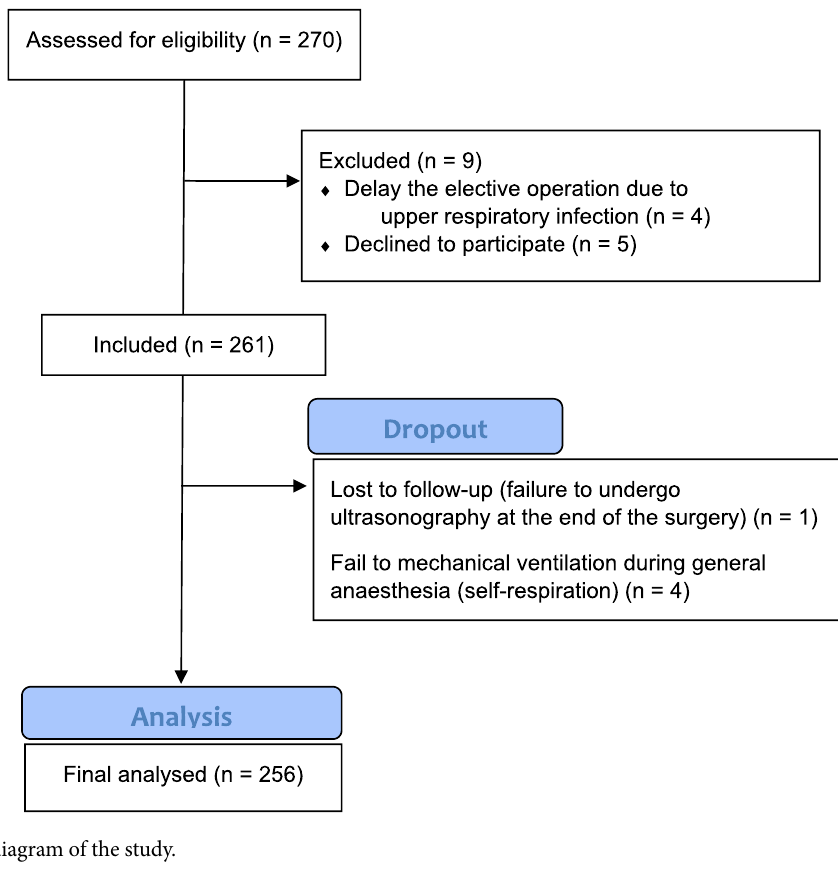
Figure 2. Flow diagram of the